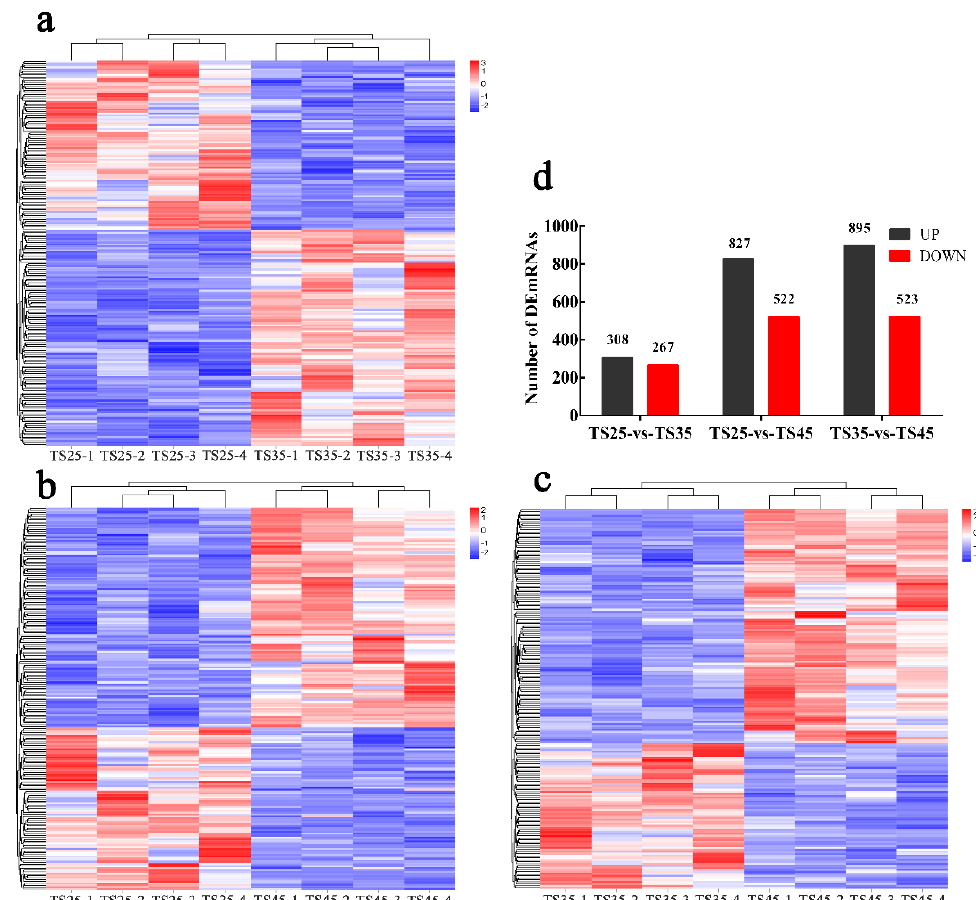
Figure 2. Results of mRNA-seq in heart tissue of Tibetan sheep at different altitudes. The Heatmap shows the relative expression pattern of DEmRNAs between groups. Each column represents a sample, and each row represents the expression of a single mRNA between different samples. The color transitions from blue (low expression) to red (high expression). ( a ) The heatmap between TS25 and TS35. ( b ) The heatmap between TS25 and TS45. ( c ) The heatmap between TS35 and TS45. ( d ) Statistical of DEmRNAs in three group. ( TS25 ) 2500 m altitude Tibetan sheep. ( TS35 ) 3500 m altitude Tibetan sheep. ( TS45 ) 4500 m altitude Tibetan sheep.